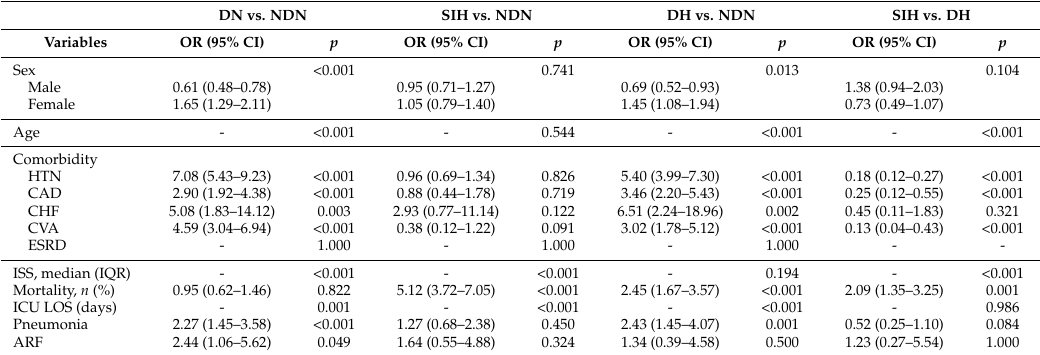
Table 2. Comparison of the characteristics, injury severities and outcomes among the patient groups. DNvs. NDN SIHvs. NDN DHvs. NDN SIHvs.